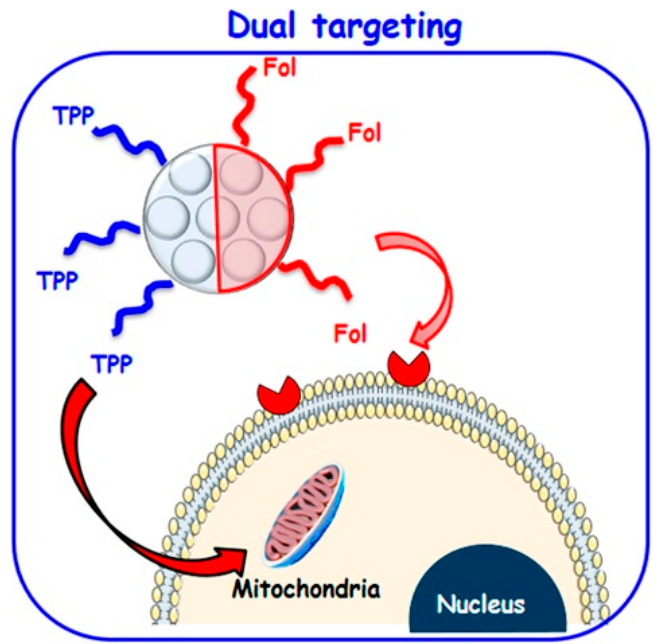
Figure 7. Dual targeting strategy to attack both tumor cell membrane and mitochondria by asymmetrically functionalized nanoparticles [118].